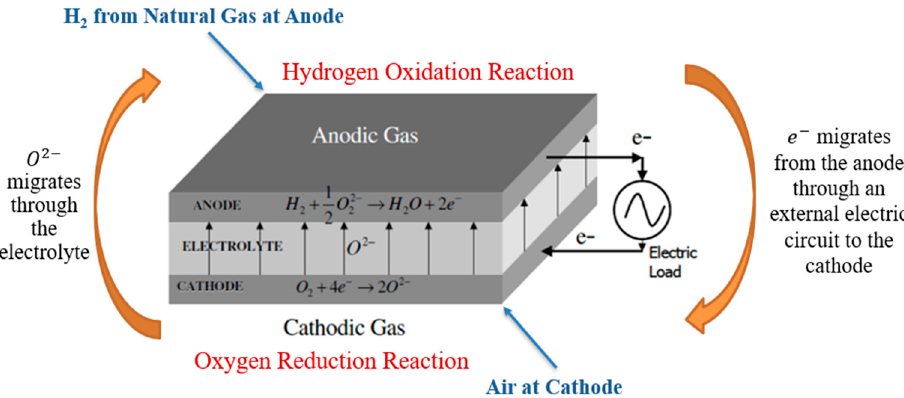
Figure 1. Schematic representation of an solid oxide fuel cell (SOFC).